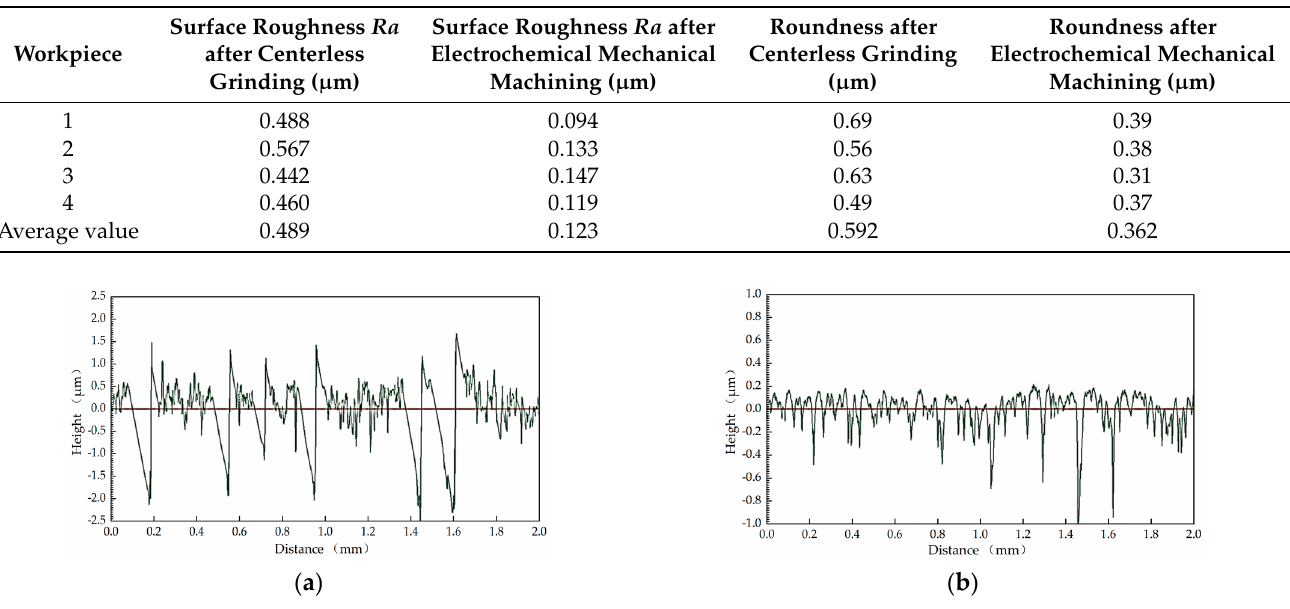
Table 15. Experimental results after centerless grinding and electrochemical mechanical machining.